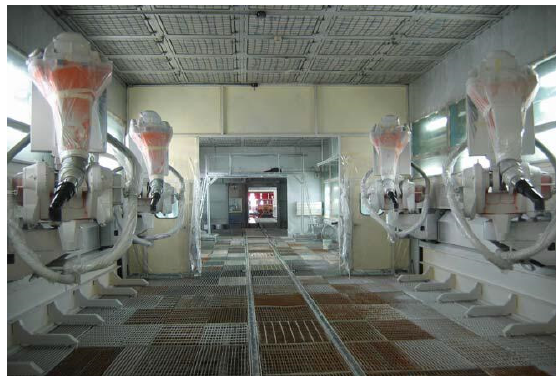
Figure 8. An automobile paint line composed by several spray ‐ painting robots.